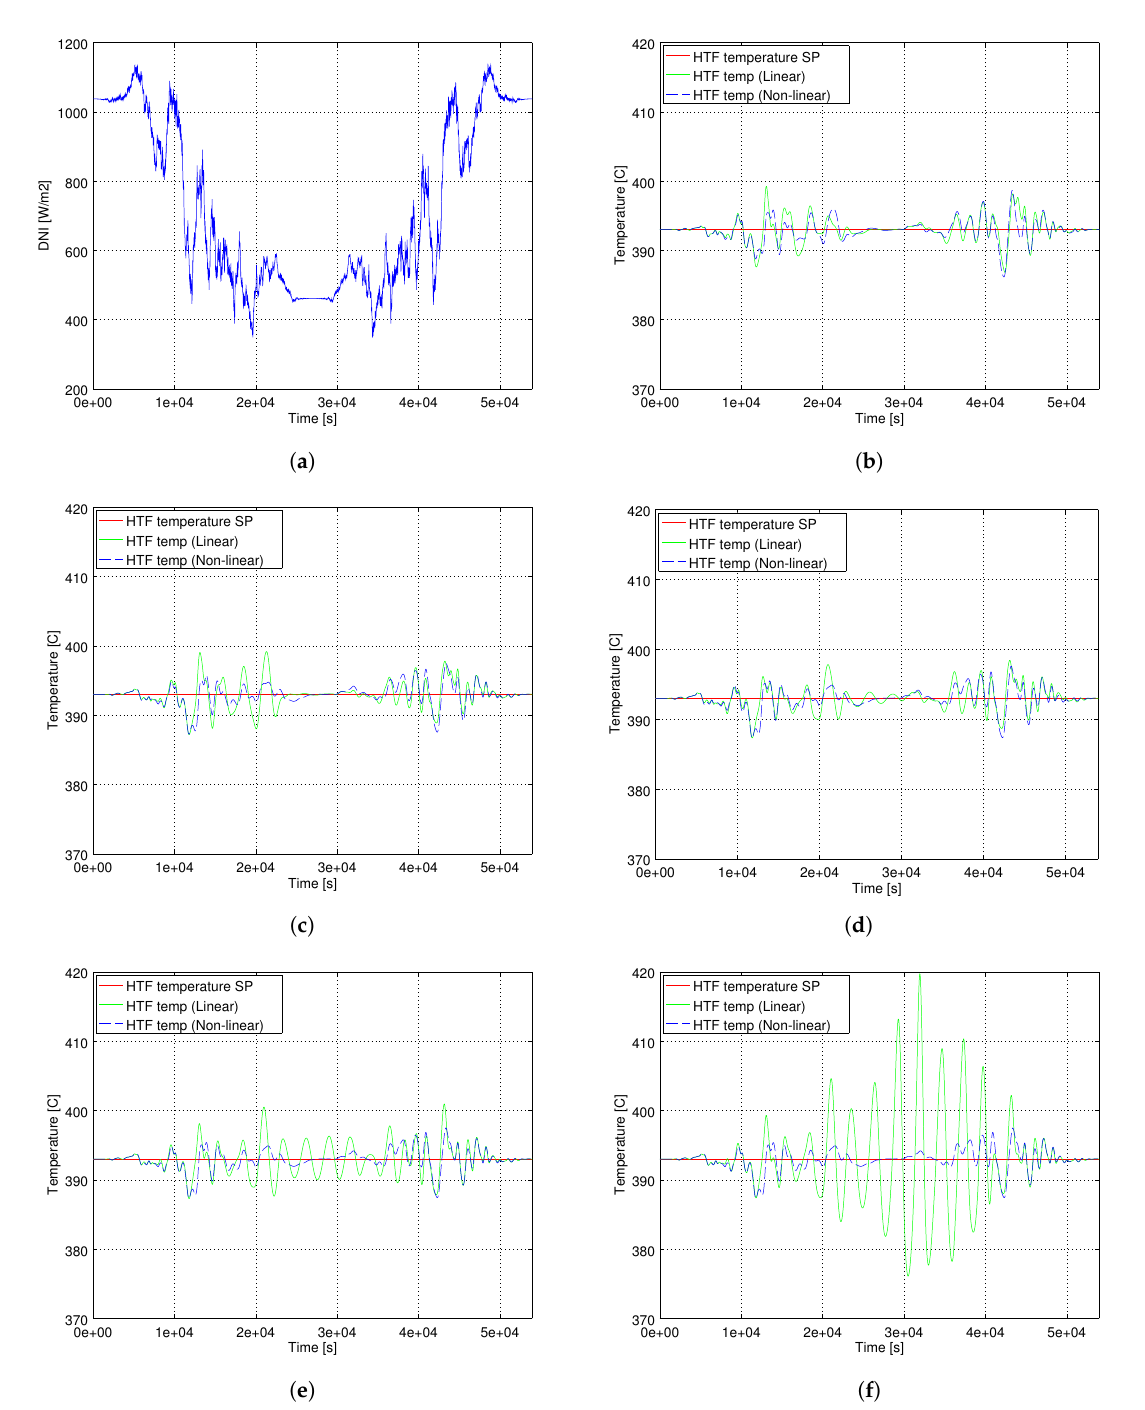
Figure 3. DNI pattern in ( a ) and linear (solid) vs. nonlinear (dashed) controller operation with different adaptation speeds in ( b – f ). Time is shown in abscissa. ( a ) DNI pattern; ( b ) γ = 0.7; ( c ) γ = 0.1; ( d ) γ = 0.01; ( e ) γ = 10 − 3 ; and ( f ) γ = 10 − 4